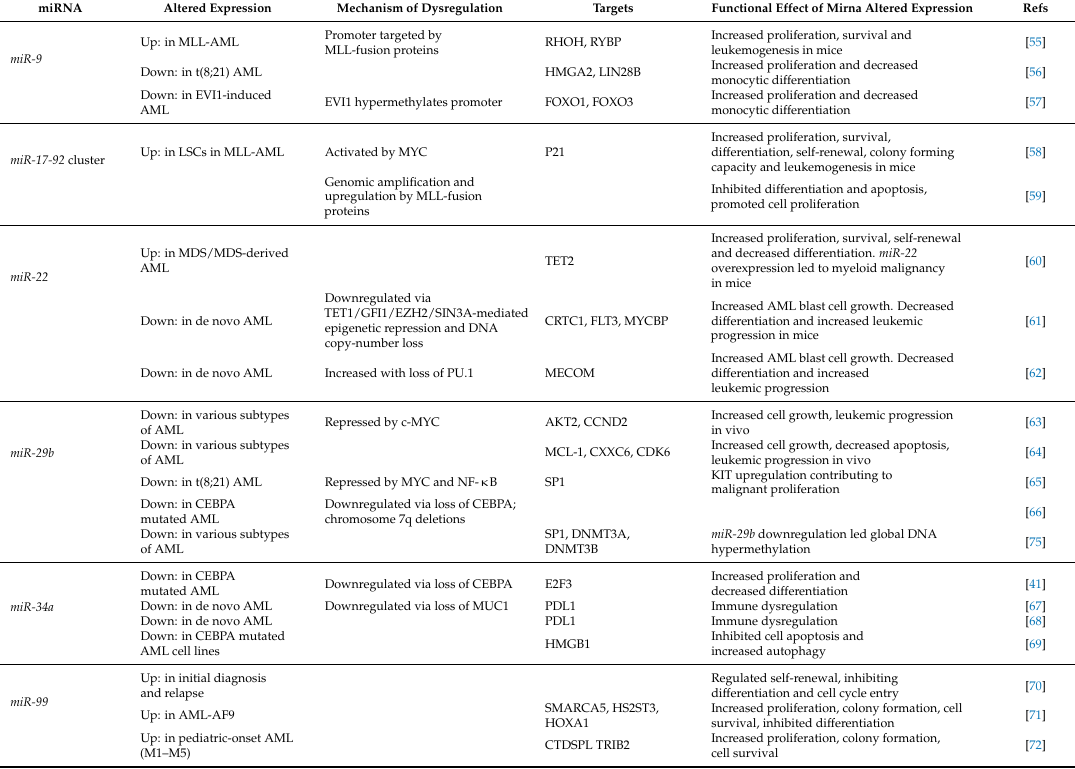
Table 2. miRNAs involved in AML